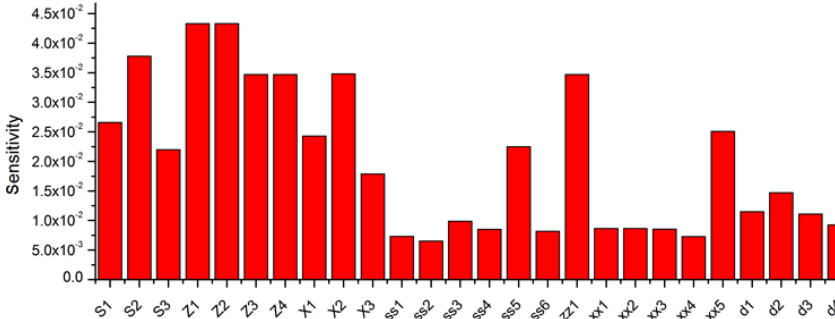
Figure 18. Sensitivity histogram of board thickness of frame composition to frame